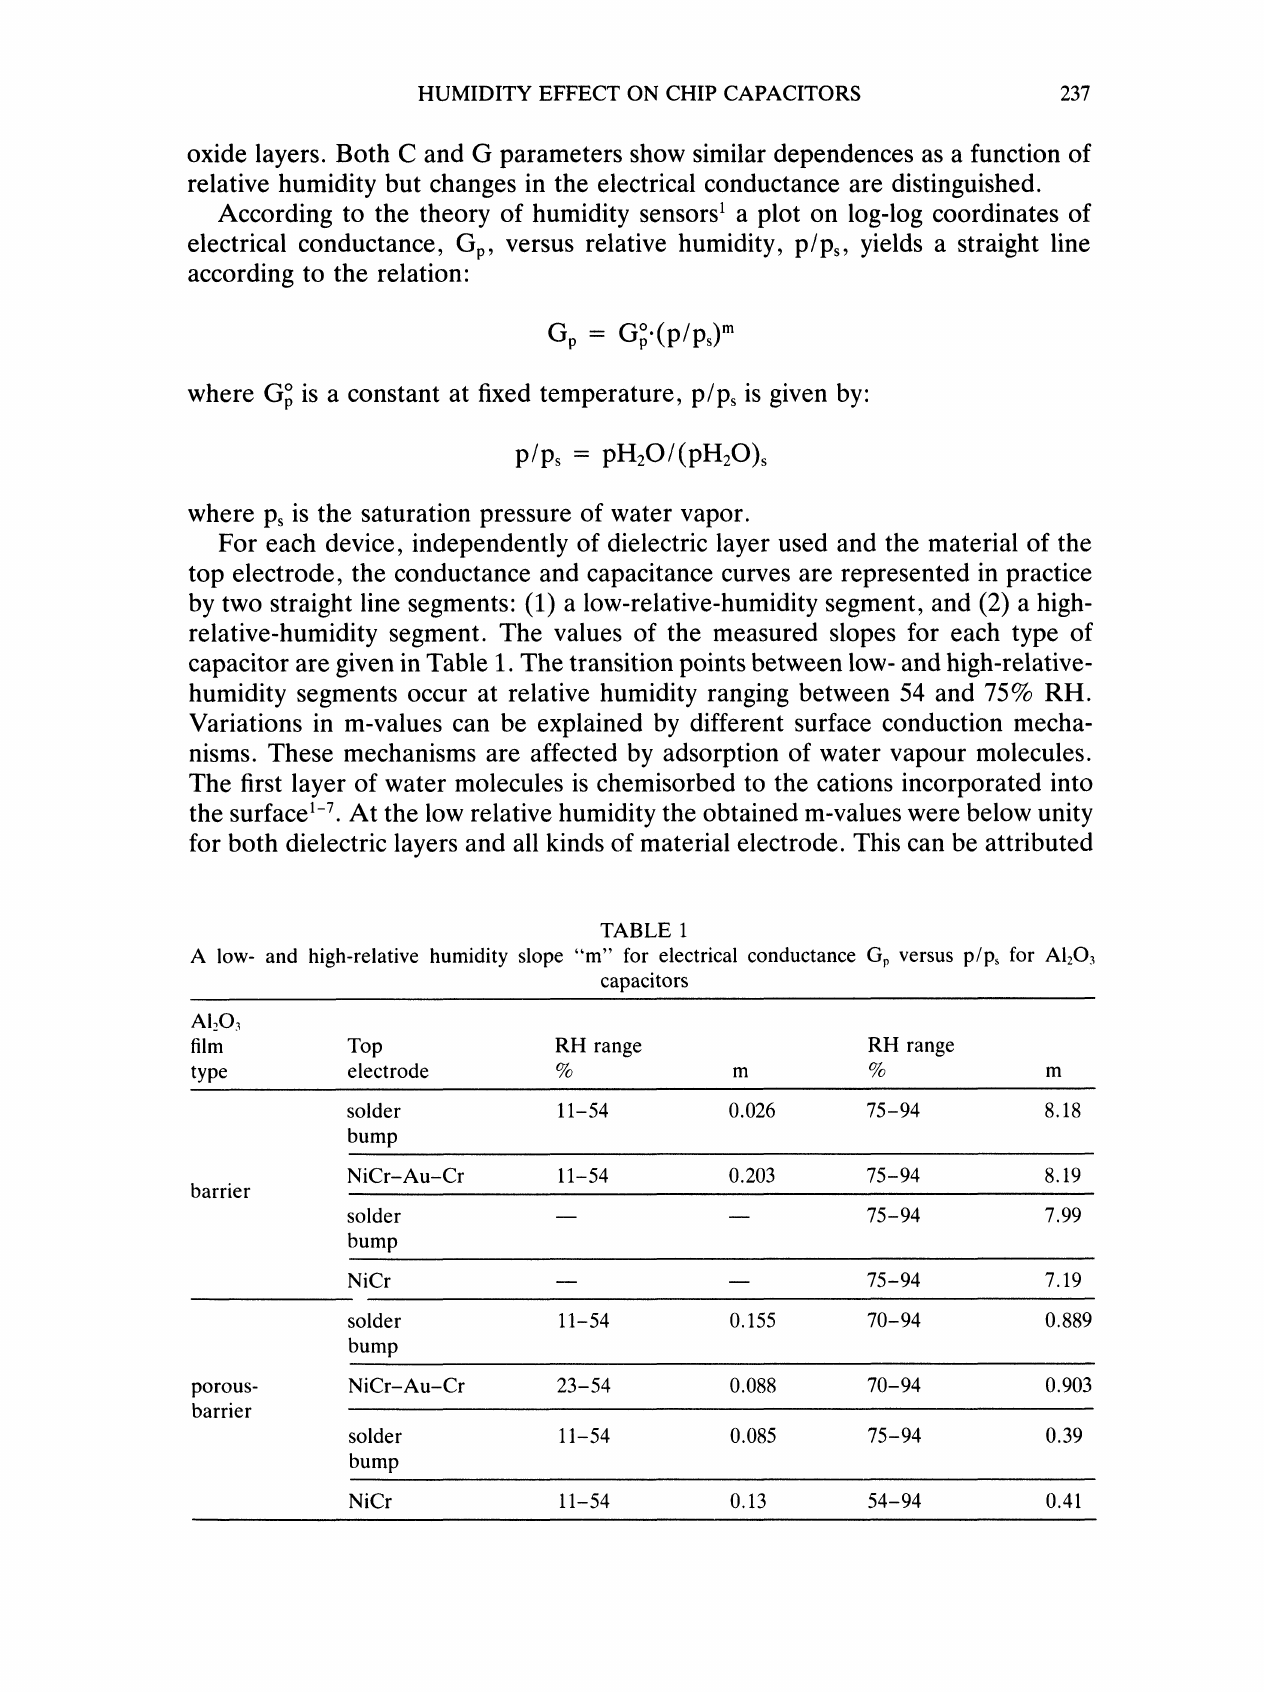
A low- and high-relative humidity slope "m" for electrical conductance Gp versus P/Ps for